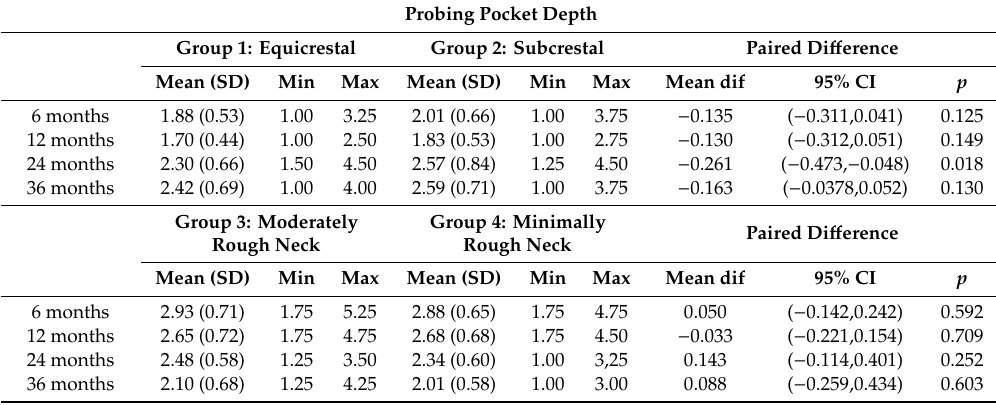
Table 4. Mean probing pocket depth on implant level at 6, 12, 24 and 36 months for each study group and the mean di ff erence between respectively equicrestally versus subcrestally placed implants and implants with a moderately rough versus minimally rough neck; p < 0.05 indicates a statistically significant di ff erence (paired t -test).